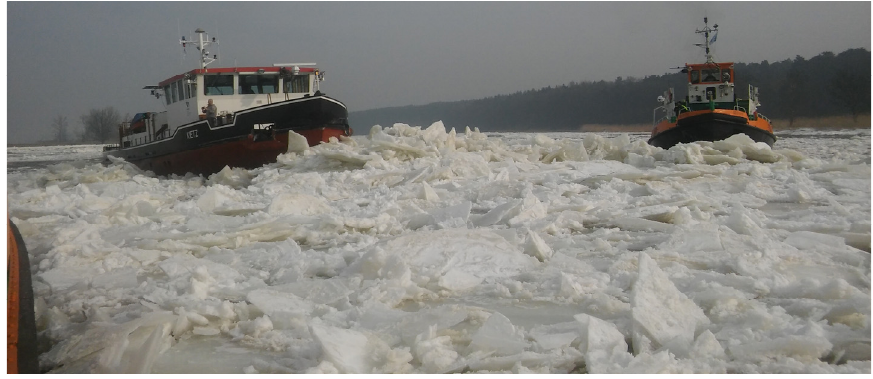
Figure 10. Icebreakers releasing an ice jam on the Oder River (source: RZGW, Szczecin). Generally, a permanent ice cover develops first on Dabie Lake in Szczecin (see map in Figure 11), where frazil ice travelling down the Oder River accumulates and juxtapositions upstream along the Oder River’s main stem and its tributaries, the Warta and Lusatian Neisse rivers. Icebreaking begins with crushing the permanent ice cover on Dabie Lake and freeing a gutter through the ice cover to make room for ice floes broken upstream along the river. Frontal icebreakers are directed upriver to break the consolidated ice cover along the river, while linear icebreakers crisscross Dabie Lake to prevent the broken ice from stagnating and refreezing.